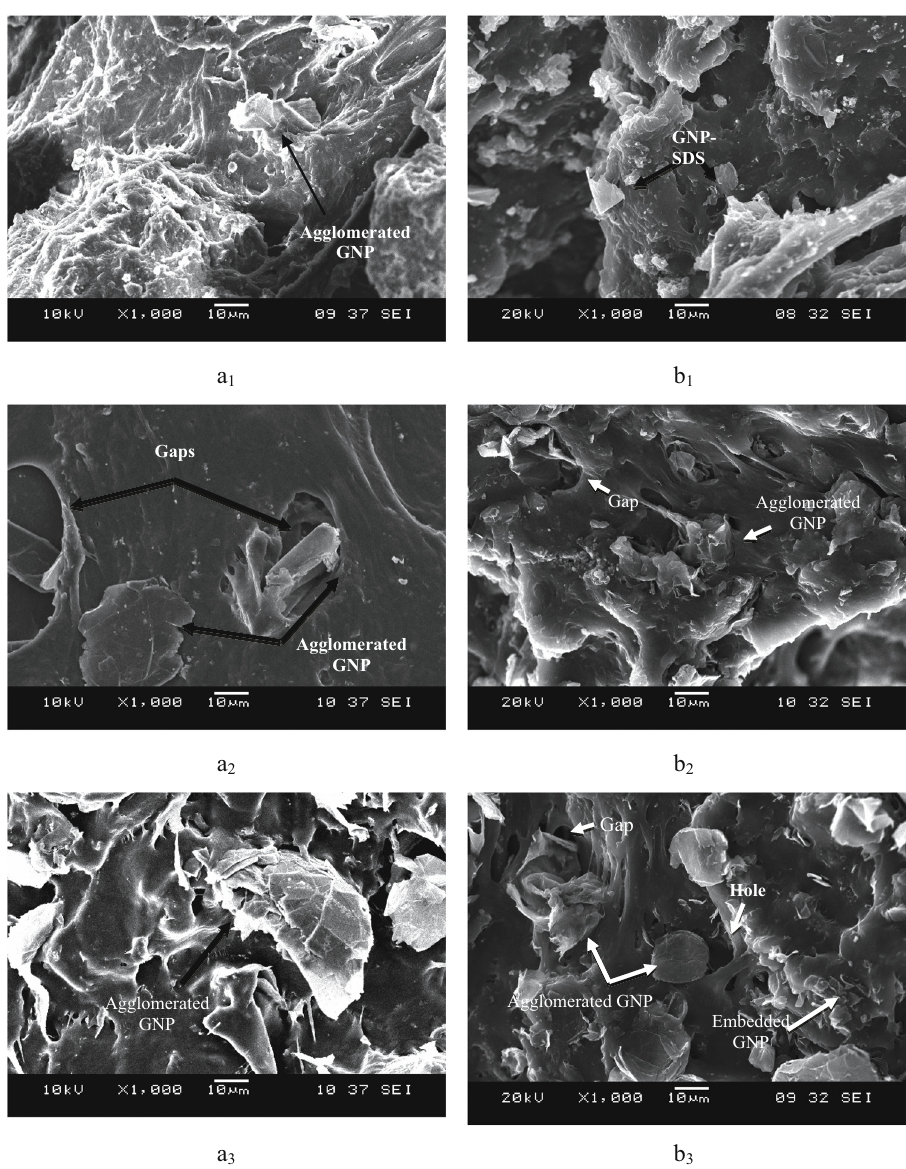
Figure 7: SEM micrographs of the tensile fracture surface of ( a ) NRL/GNP - pristine and ( b ) NRL/GNP – SDS composites at: ( 1 ) 1 phr, ( 2 ) 3 phr, and ( 3 ) 9 phr of GNP loadings,